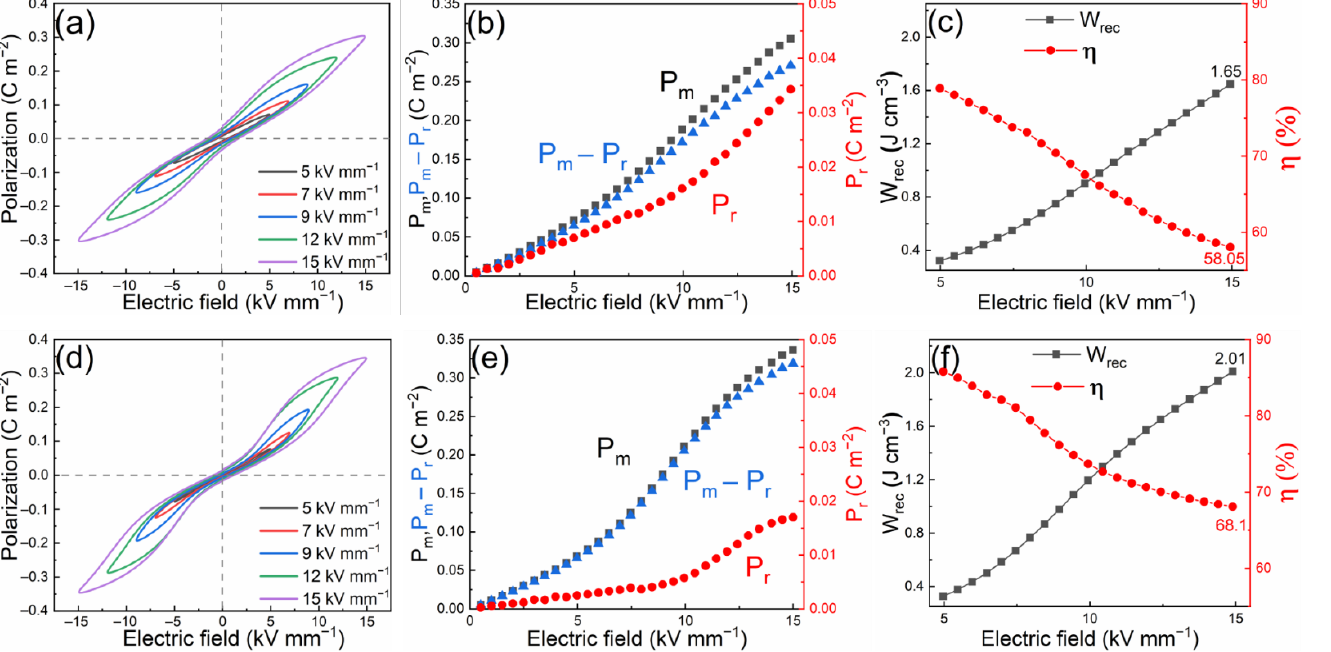
Figure 6. Polarization – electric field (P – E) loops of 0.7BF – 0.3BT – 2Nb ceramics under different electric fields at ( a ) 25 °C and ( d ) 75 °C. Maximum and remanent polarization (P m and P r ) and difference (P m – P r ) as a function of electric field for 0.7BF – 0.3BT – 2Nb at ( b ) 25 °C and ( e ) 75 °C. Recoverable energy density (W rec ) and energy storage efficiency (η) as a function of electric field of 0.7BF– 0.3BT – 2Nb at ( c ) 25 °C and ( f ) 75 °C.